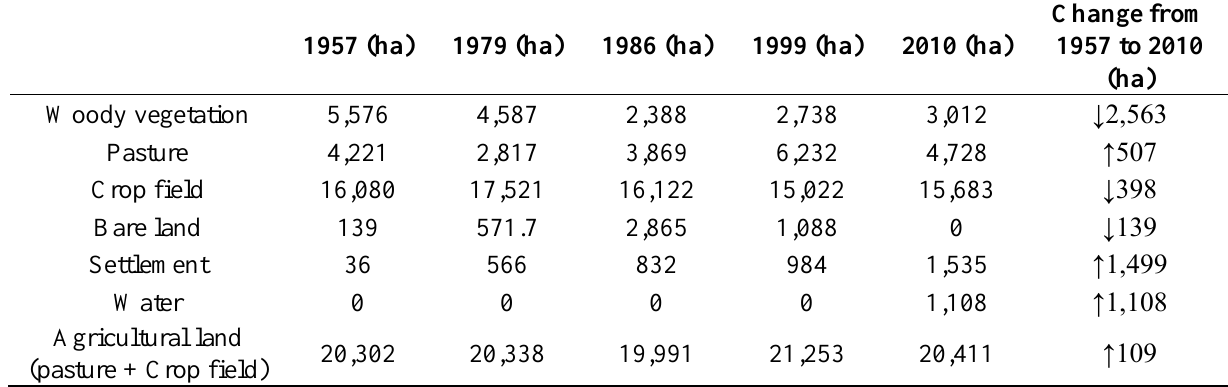
Table 3. Koga catchment land use/cover classes from 1957–2010 in hectares.